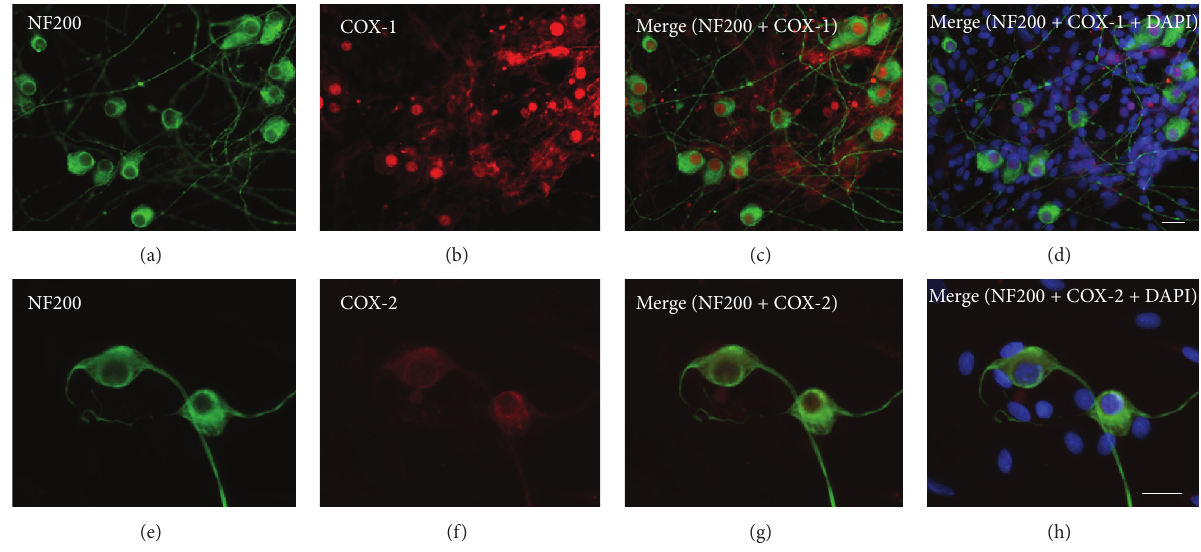
Figure 1: Immunofluorescence of COX-1 and COX-2 in VGNs. All of the neurons identified as NF200-positive (a) expressed COX-1 in either the cytoplasm or nuclei (b) and had an increased signal in the nuclei as confirmed by the merged images ((c), (d)). In comparison, weak COX-2-specific staining was identified mainly in the cytoplasm of VGNs as shown in ((e), (f)) and was confirmed by the merged images ((g), (h)). Scale bar, 25